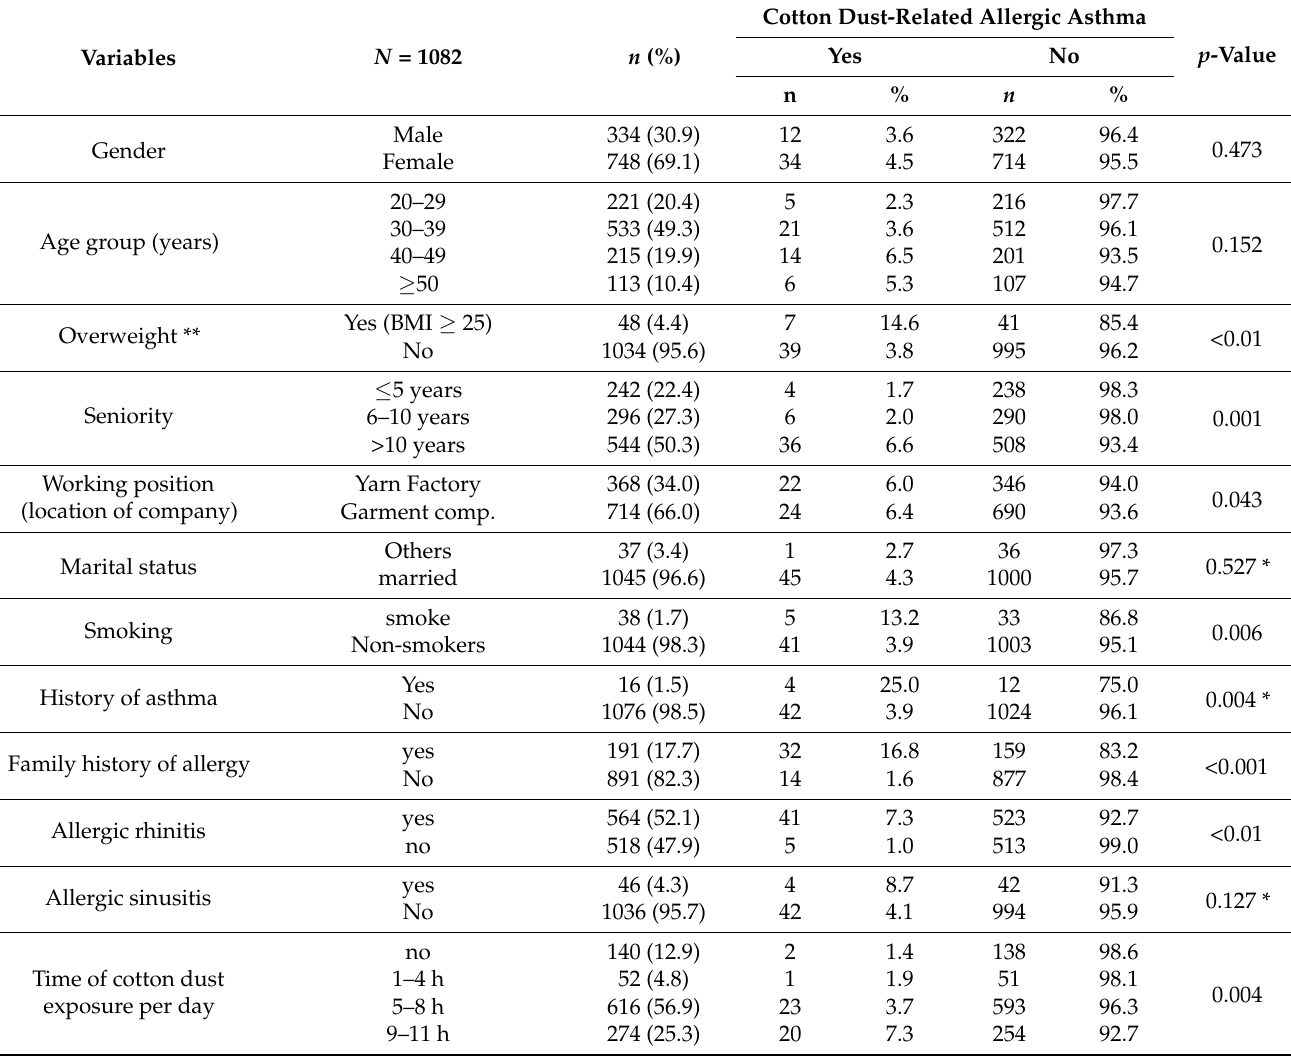
Table 1. Demographic and cotton dust-related allergic asthma characteristics among